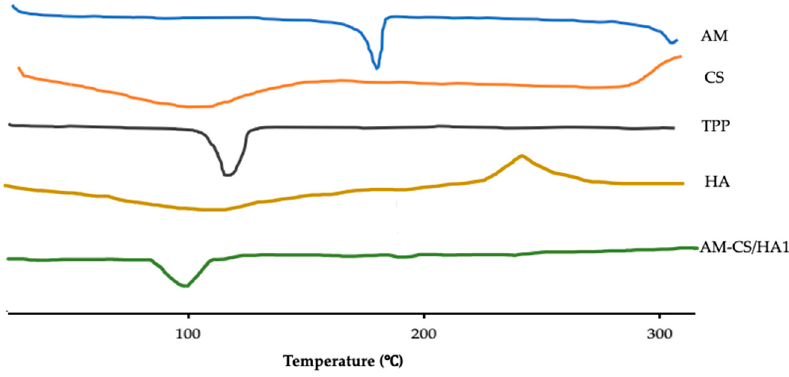
Figure 4. DSC thermographs of raw material and AM-CS/HA1.